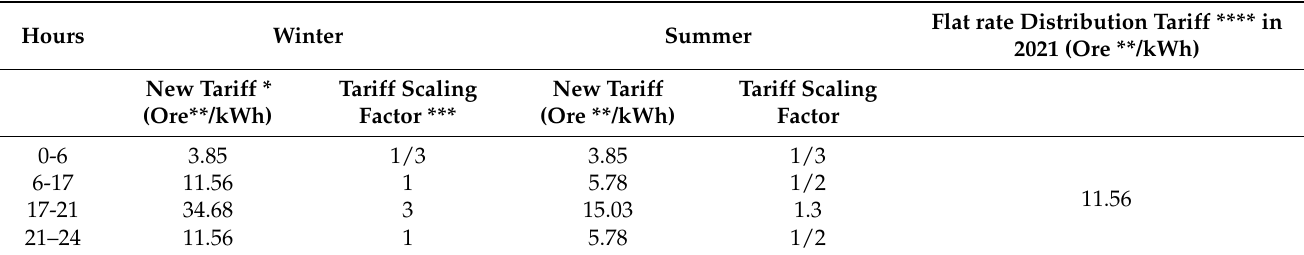
Table 12. Load periods and Tariff scaling factor in new distribution tariffs for households [49–51]. Hours